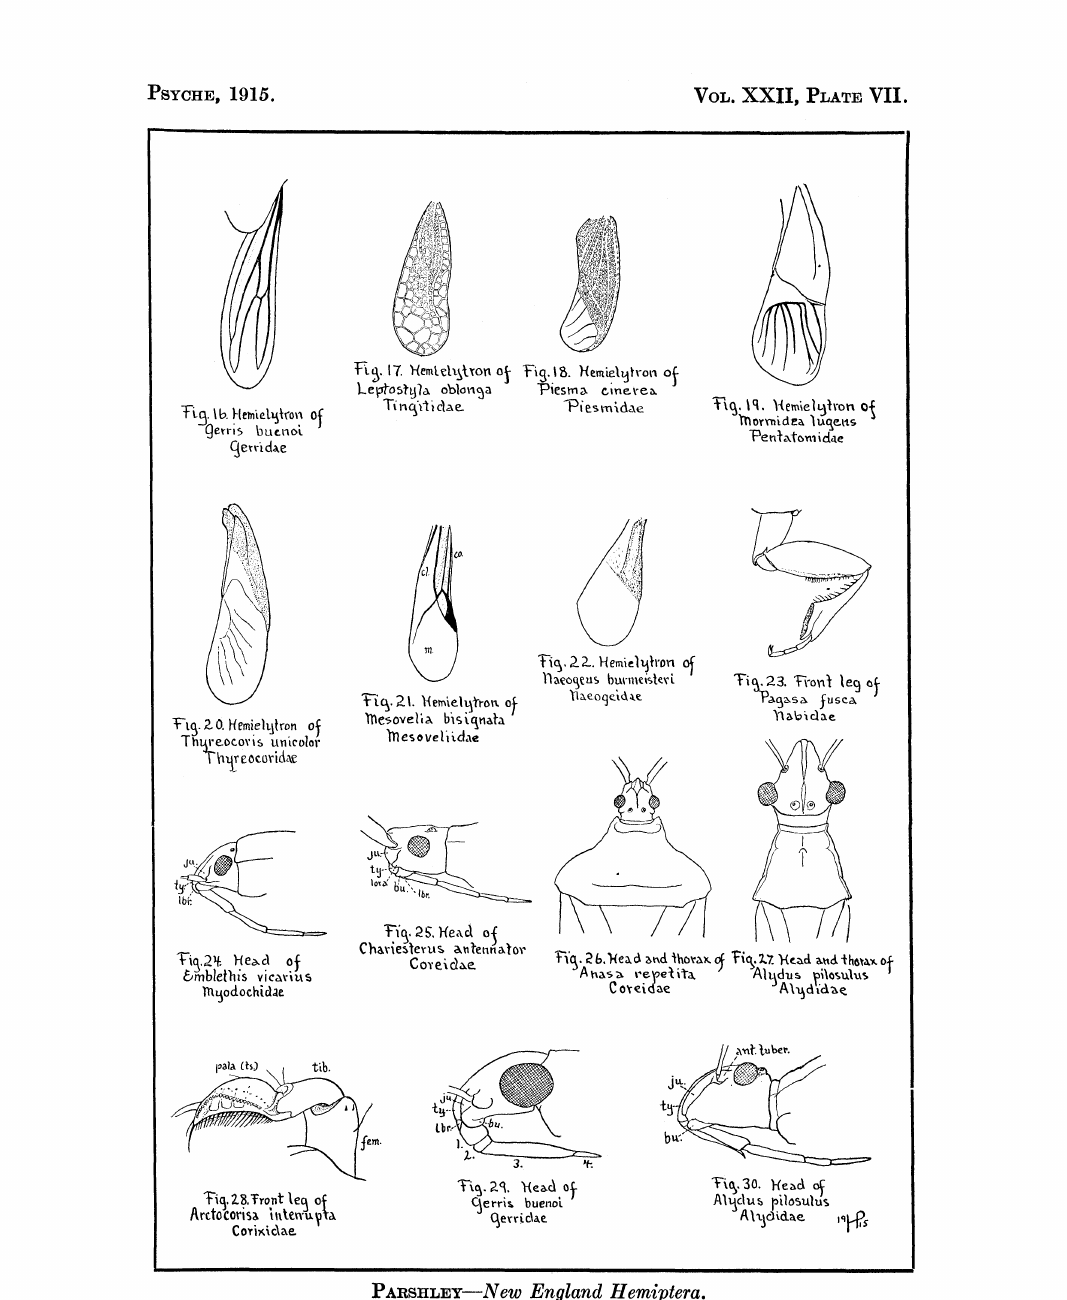
PARStILEY--New England